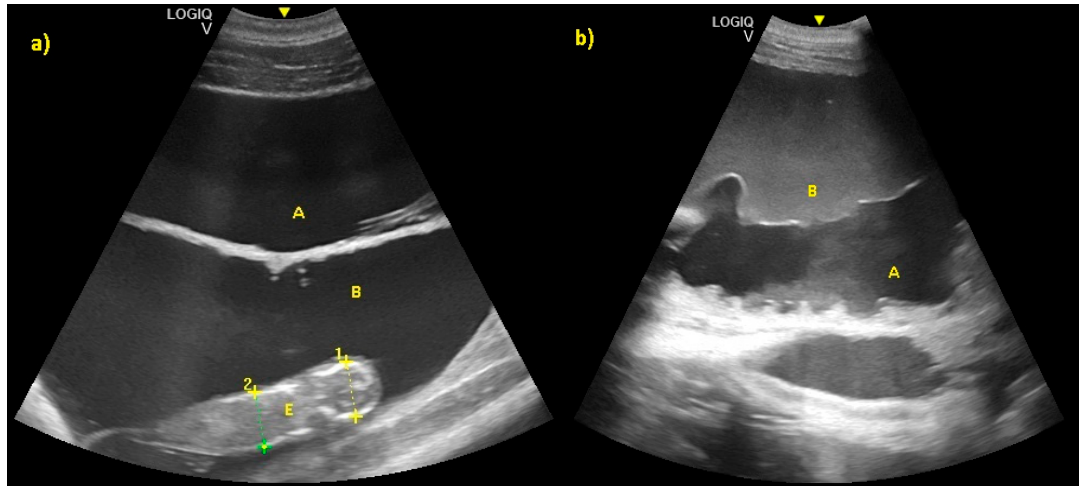
Figure 11. ( a ) Allantoic (A) and amniotic fluid (B) in early stage of pregnancy. ( b ) Allantoic fluid appears as an anechoic fluid (A), and the amniotic fluid appears as a hyper-echoic fluid, with an increasing amount of echoic particles during the last period of pregnancy (B).